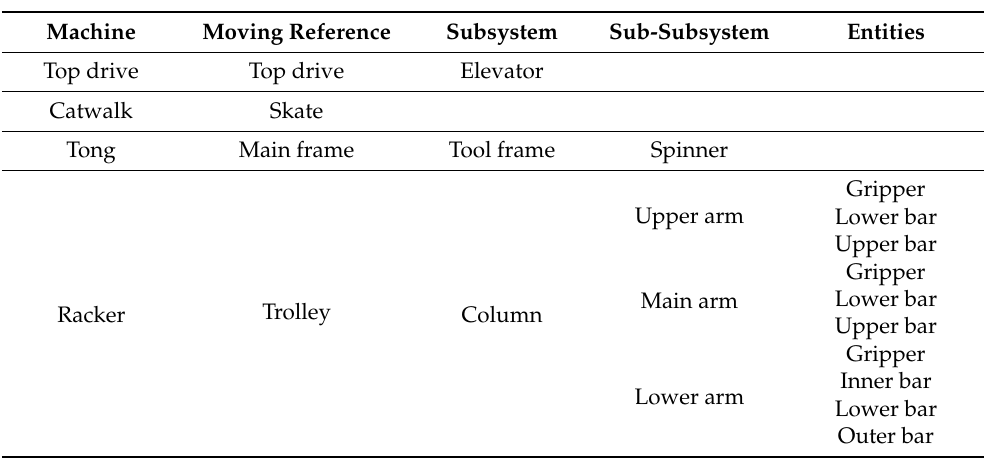
Table 1. Hierarchy of the drilling machines on the drill floor.